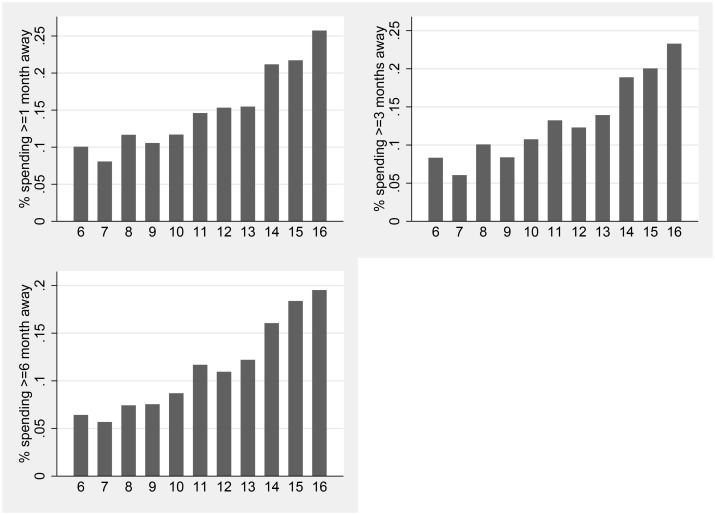
Children’s migration by age.Percentage of respondents who have spent at least 1, 3 or 6 months away from home over the last 12 months. Source: Uganda National Panel Survey. 2009-2010.